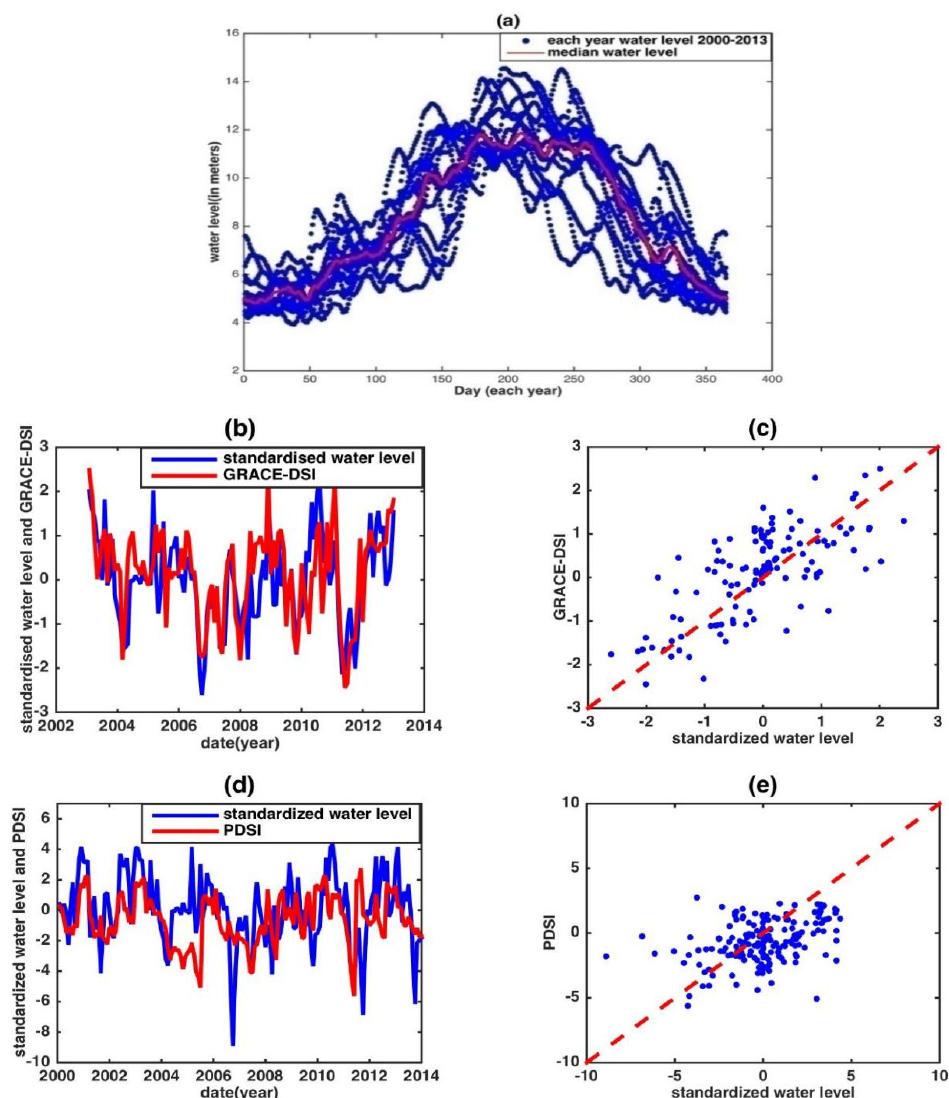
Figure 4. Time series of water levels recorded at ( a ) Datong station arranged by year; and ( b , c ) the standardized water level against the GRACE-DSI value and ( d , e ) the PDSI value. The left-hand side gives the time series comparisons of drought indices, and the right-hand side shows the corresponding scatter plots.